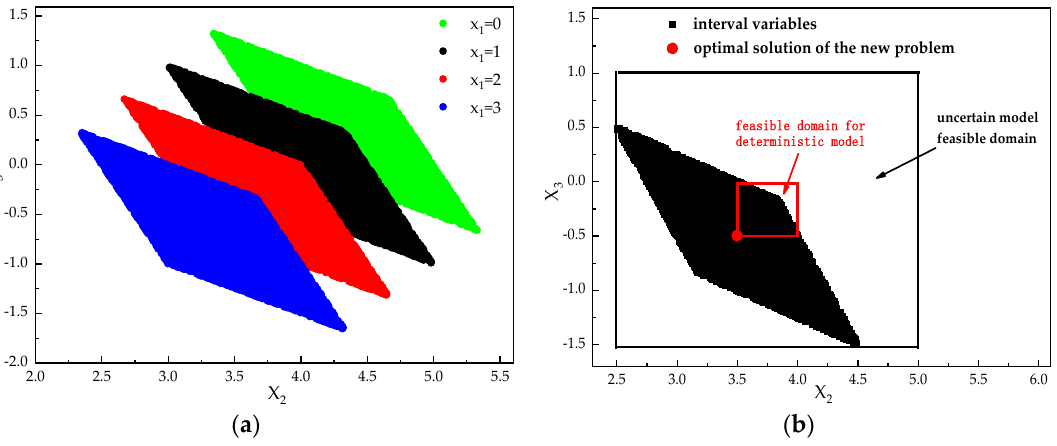
Figure 1. ( a ) Regions of state variable values under different control variable values; ( b ) feasible regions of state variables in the LIP and the LP models.